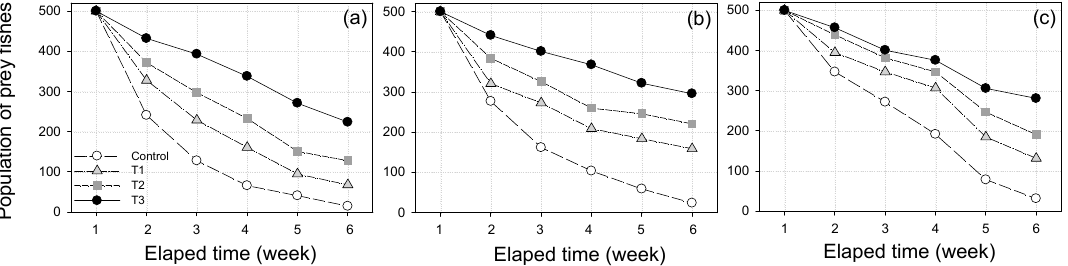
Figure 3. Variation in population of prey fish over six weeks: ( a ) Period 1; ( b ) Period 2; and ( c ) Period 3.